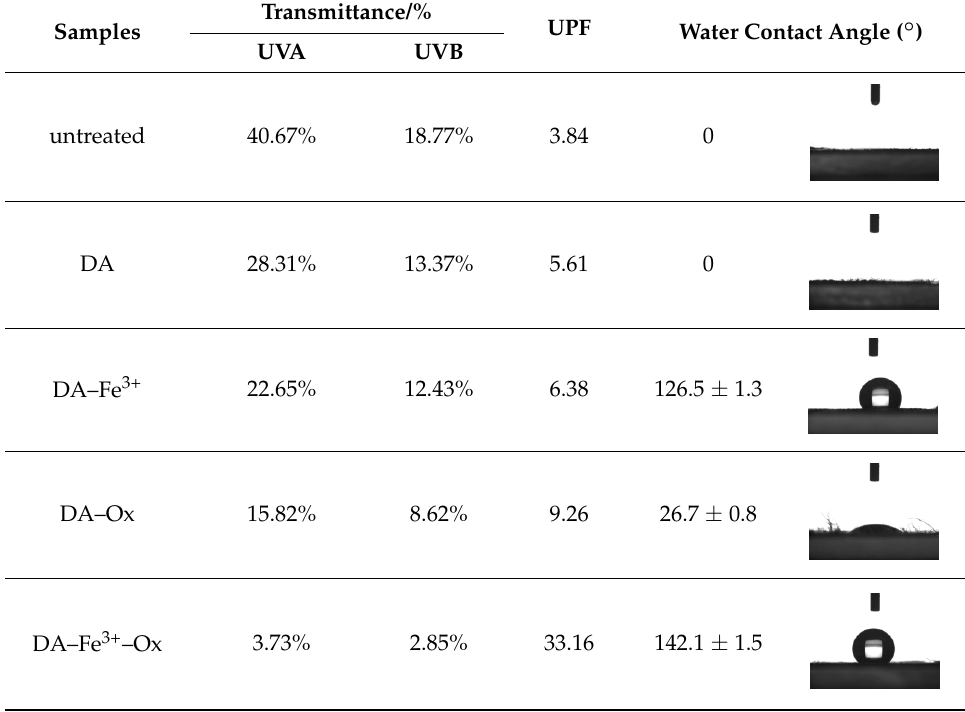
Table 3. UV protection factor (UPF) and water contact angle (CA) of silk fabric samples.